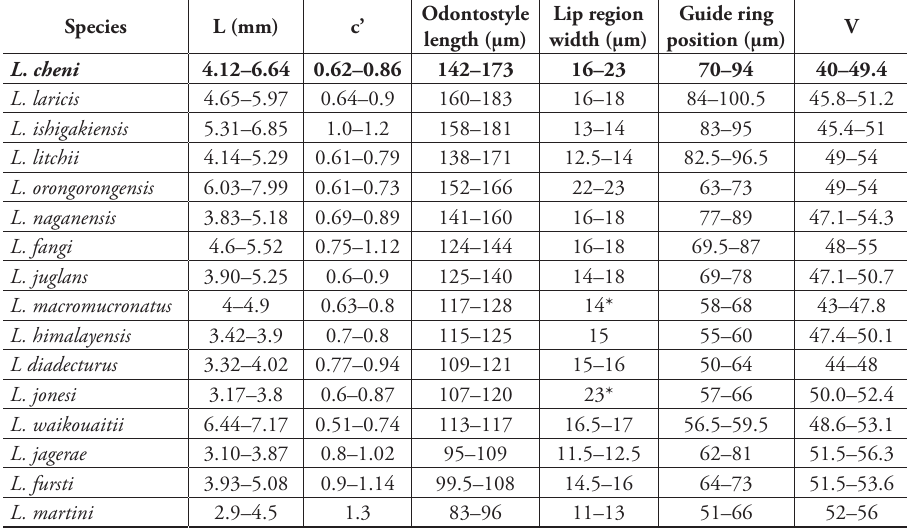
Table 4. Morphometric comparisons of Longidorus cheni sp. n. and related Longidorus spp. with close morphological similarities based on polytomous key for identification of species (Cheng et al.